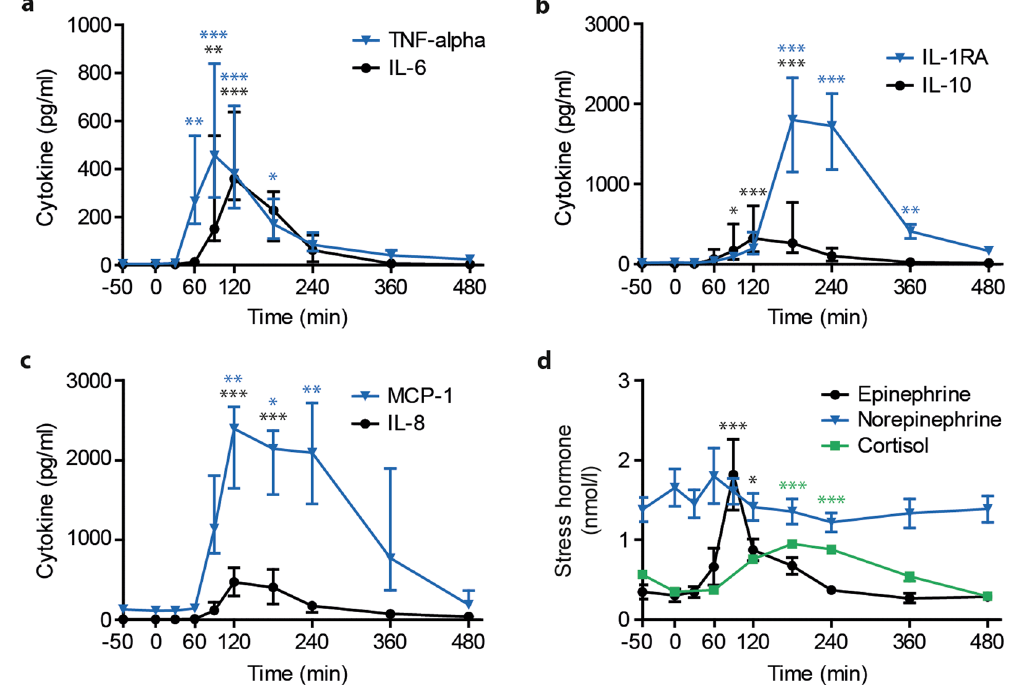
Figure 4. Systemic inflammation and stress response during human endotoxemia. Time course of cytokine levels as determined in plasma for (a) pro-inflammatory cytokines interleukin-6 (IL-6) and tumor necrosis factor- α (TNF- α ), (b) anti-inflammatory cytokines interleukin-1 receptor antagonist (IL-1RA) and interleukin-10 (IL-10) and (c) chemotactic cytokines monocyte chemoattractant protein-1 (MCP-1) and interleukin-8 (IL-8) (n = 8). (d) Time dependent changes in plasma levels of epinephrine, norepinephrine and cortisol. Data points (n = 8) show median with interquartile range, asterisks indicate significance compared to baseline (t = −